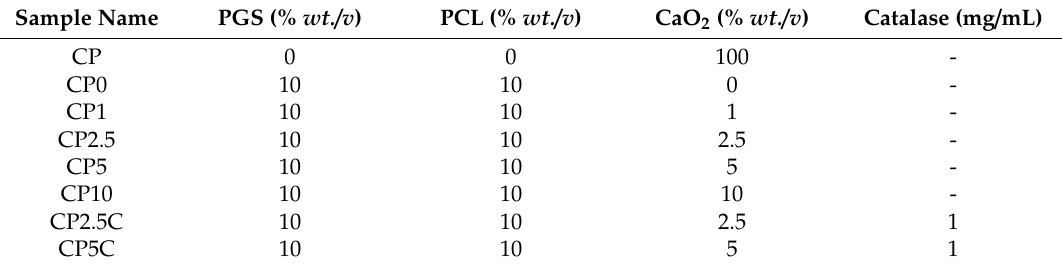
Table 1. Abbreviations and compositions of prepared sca ff